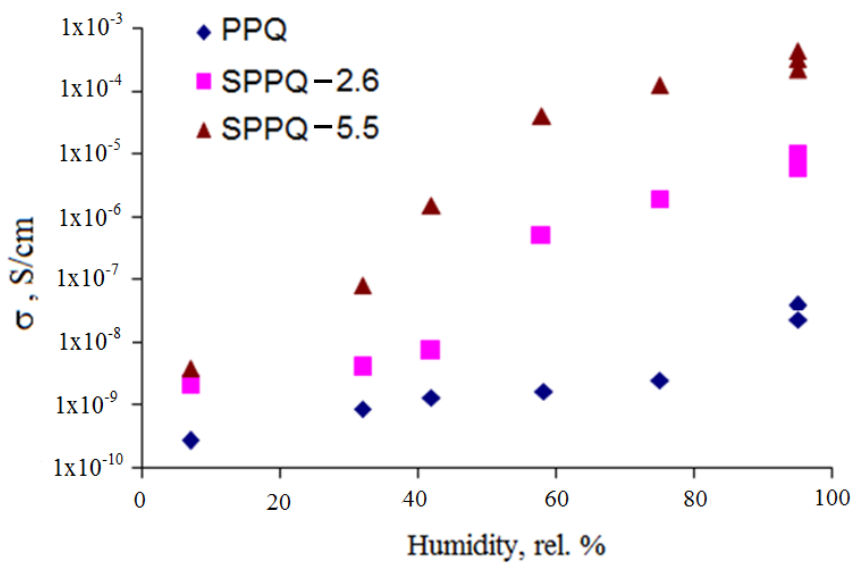
Figure 12. Dependence of the proton conductivity of the compressed PPQ and SPPQ powders on the ambient humidity at 23 °C.